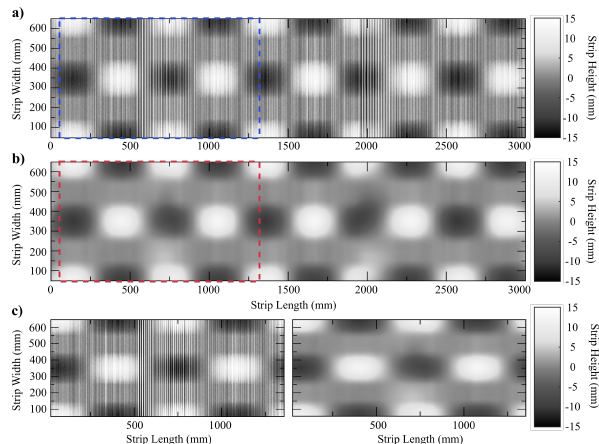
Figure 10. Visualization as a grayscale image of the synthetic surface results of the interpolation with Hermite splines.